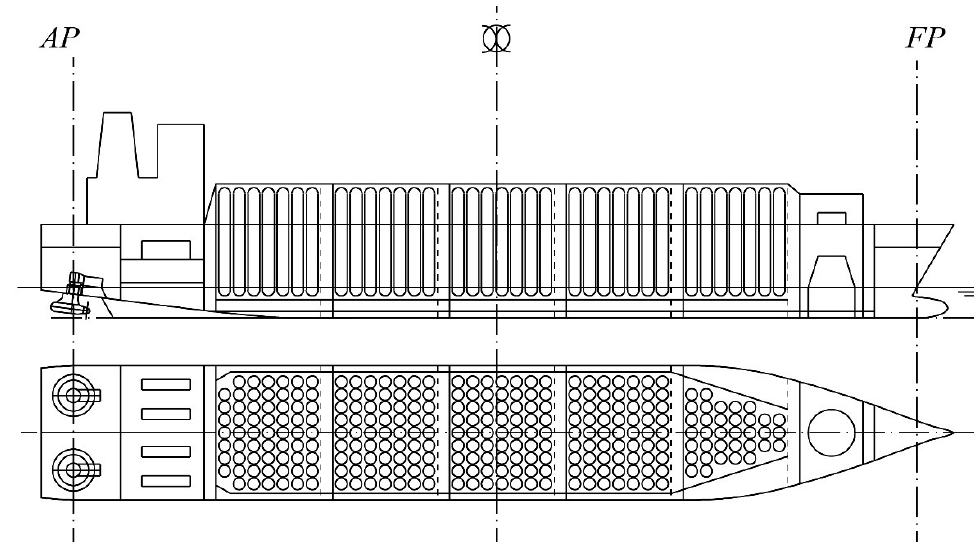
Figure 2. Typical layout of a podded CNG ship with STL